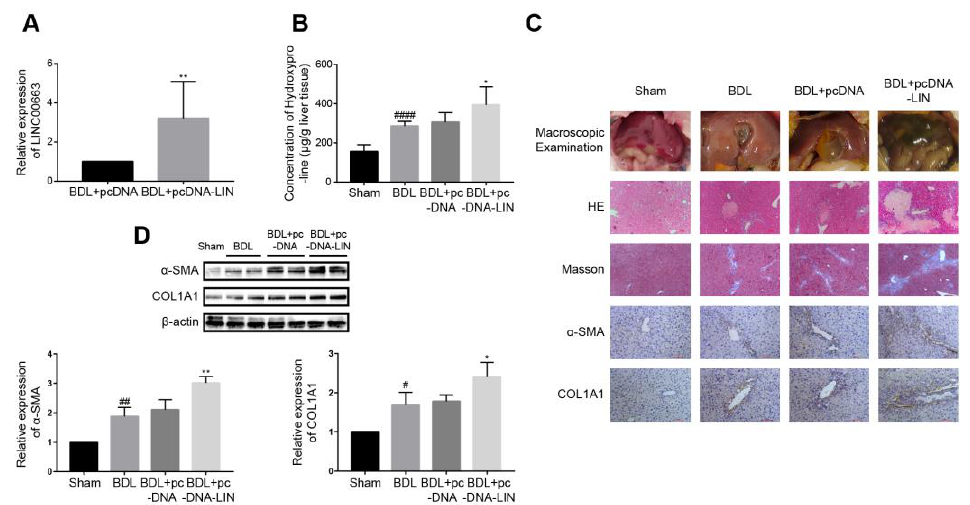
Figure 5. Overexpression of LINC00663 aggravated BDL-induced hepatic fibrosis in vivo. ( A ) RT-qPCR analysis showed LINC00663 expression in the liver of BDL mice administered pcDNA-LINC00663 (pcDNA-LIN) or negative control (NC) (n = 7 per group). ( B ) Quantification of hepatic hydroxyproline content. The data were expressed as hydroxyproline ( µ g) per liver wet weight (g) (n = 7 per group). ( C ) Liver fibrosis was evaluated by macroscopic examination, HE staining, Masson’s staining and IHC in sham or BDL mice administered pcDNA-LIN or NC. Scale bars, 100 µ m for HE (objective, × 10), Masson’s staining (objective, × 10) and IHC (objective, × 20). ( D ) Relative expression of α -SMA and COL1A1 in BDL mice transfected with pcDNA-LIN detected by WB. * p < 0.05, ** p < 0.01. # p < 0.05, ## p < 0.01, #### p < 0.0001. * vs. BDL+ pcDNA, # vs. Sham. Each experiment was repeated three times and similar results were obtained. BDL, bile duct ligation; HE, hematoxylin and eosin; IHC, immunohistochemistry; NC, negative control; RT-qPCR, real-time quantitative PCR. Table 4. Serum ALT and AST levels of mice in each group (mean ± SD, n = 7). Group ALT (U/L)